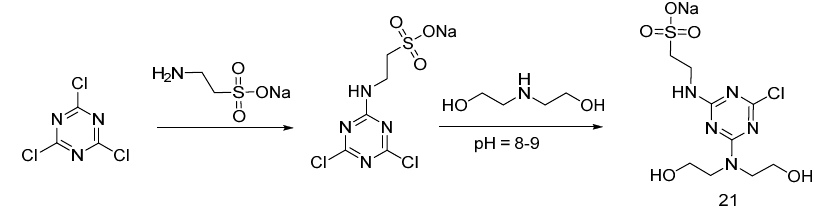
Figure 13. Synthesis of S-N flame retardant containing triazine ( 21 ).